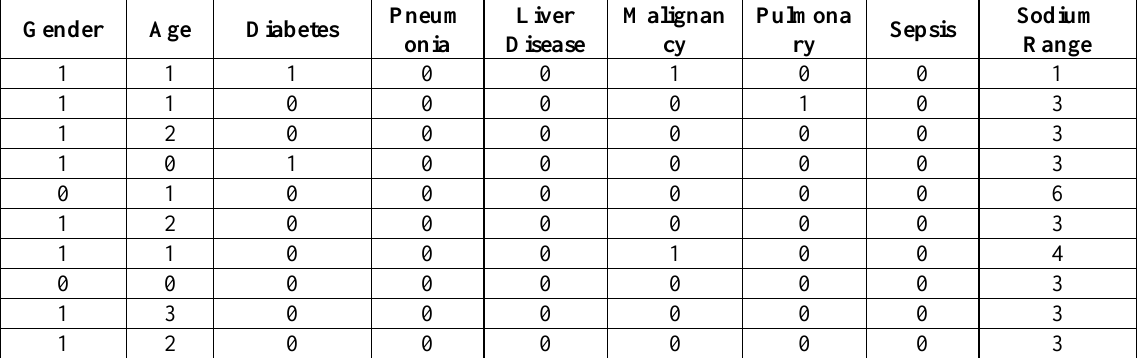
Table.1 Sample record of cleaned